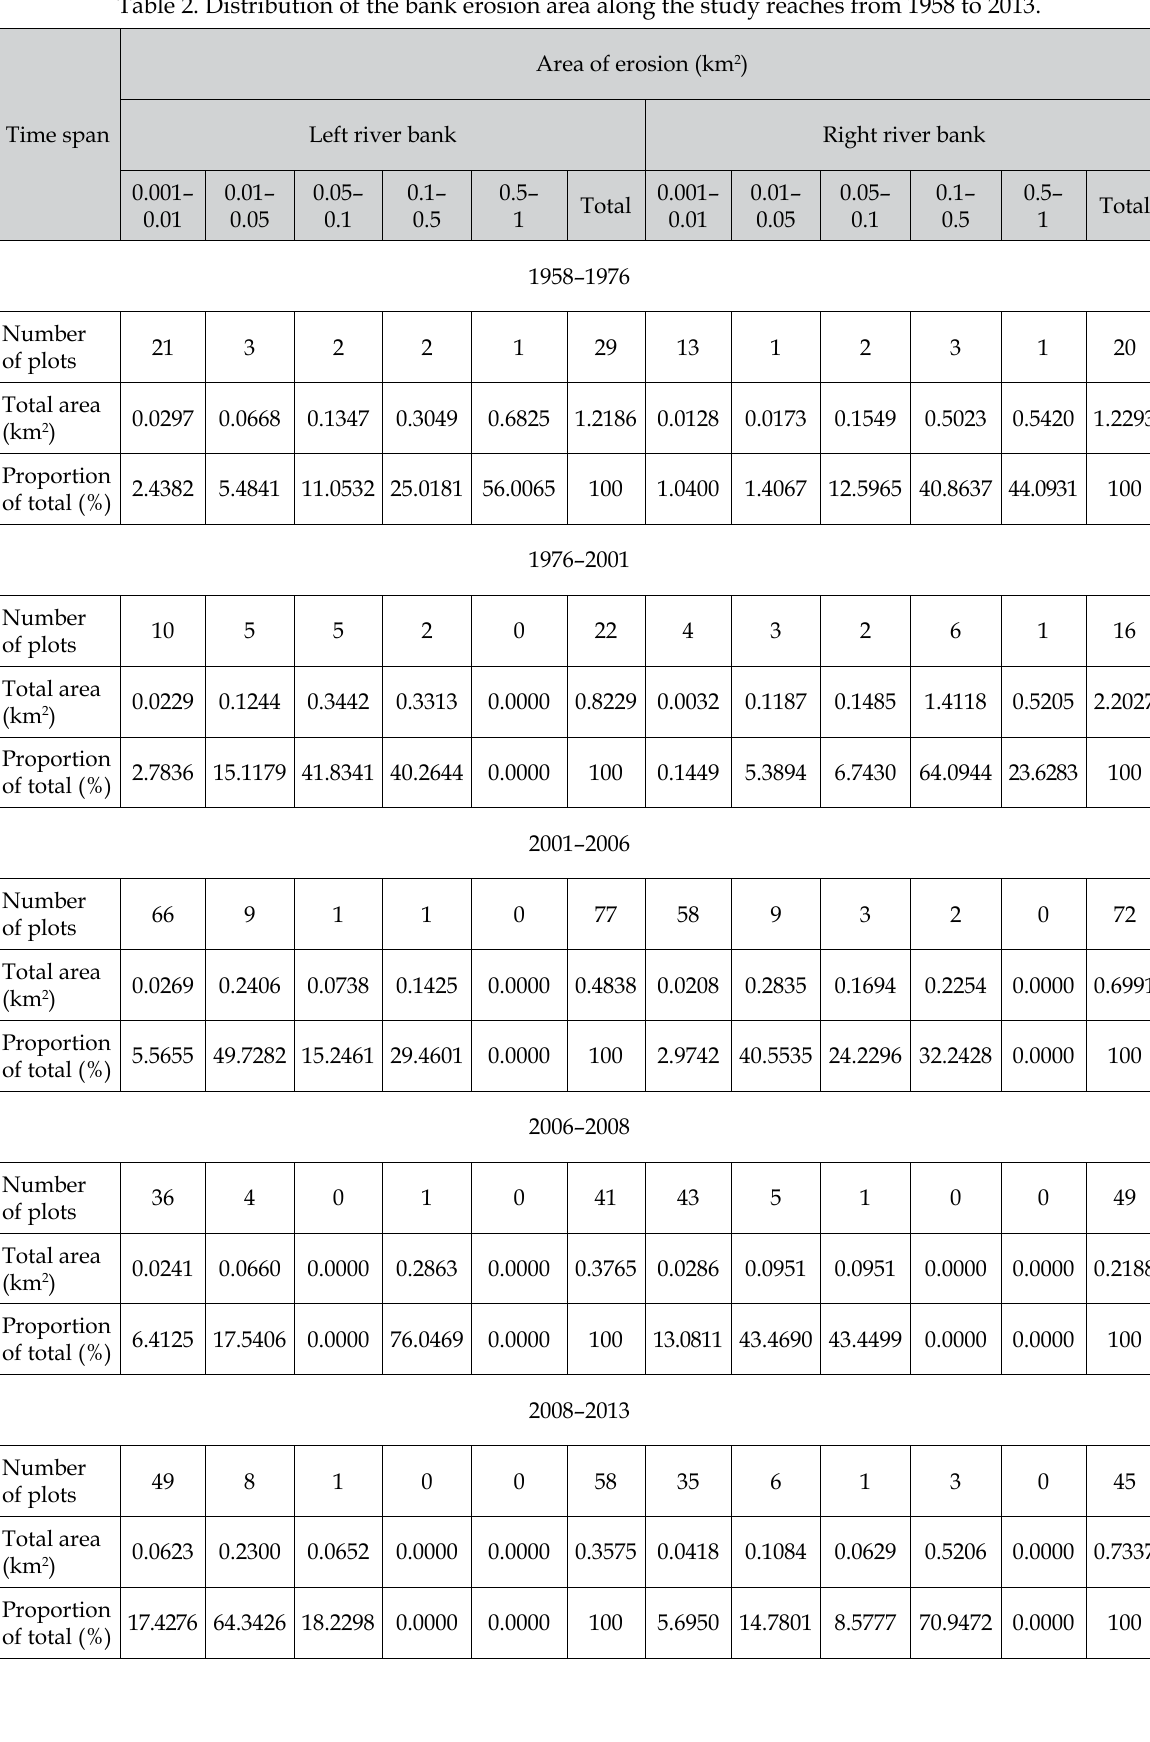
Table 2. Distribution of the bank erosion area along the study reaches from 1958 to